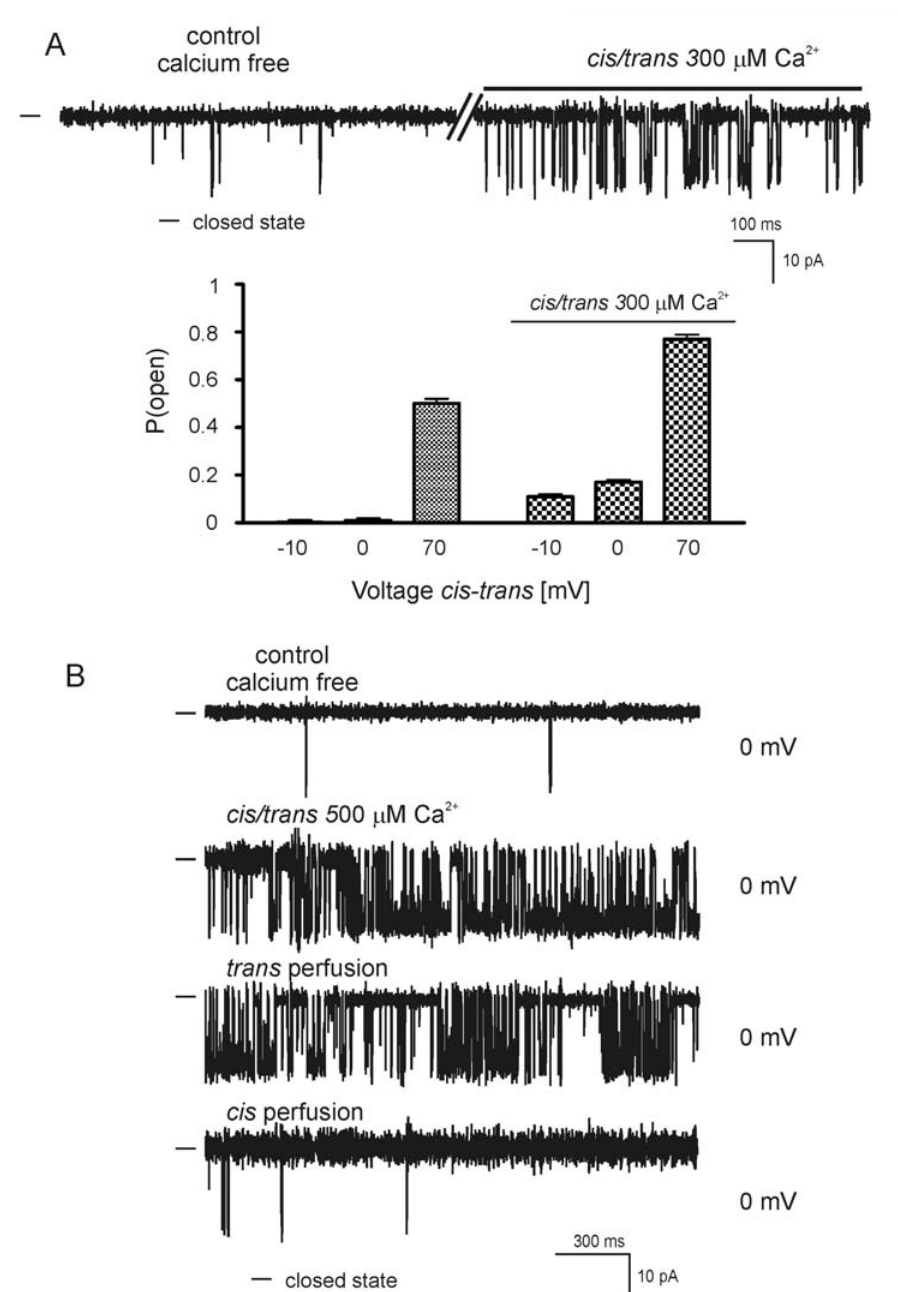
Figure 4. Ca 2+ effects on the activity of the mitoBK